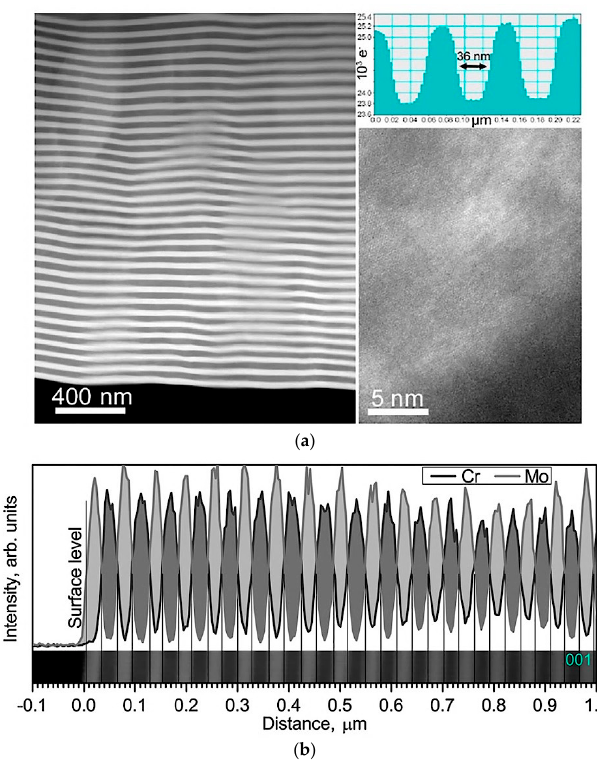
Figure 9. SEM images of CrN/MoN coatings with bilayer thickness of ( a ) 1.18 μ m and ( b ) 44 nm. Reprinted with permission from [126] 2017 Elsevier.